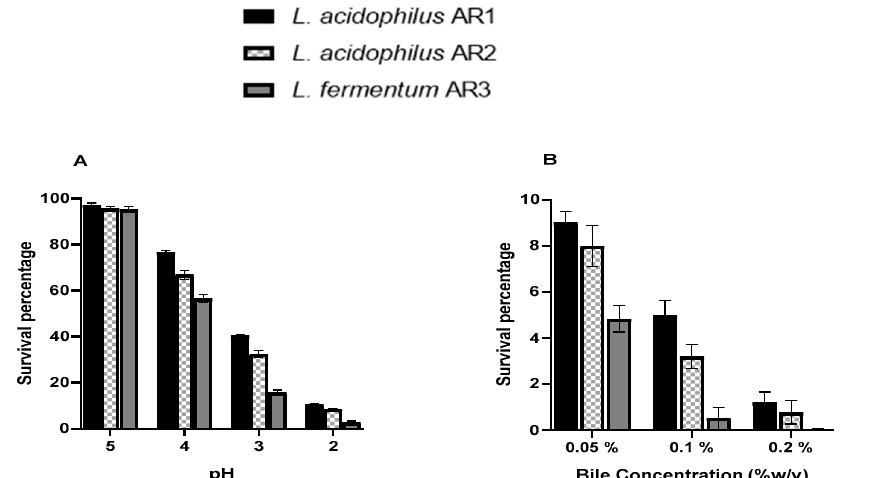
Figure 2. pH ( A ) and bile ( B ) resistance assays of L. acidophilus AR1, L. acidophilus AR2, and L. fermentum AR3.